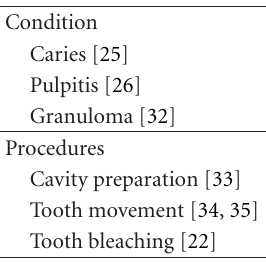
Table 2: Conditions and dental care or orthodontic procedures associated with increased substance P